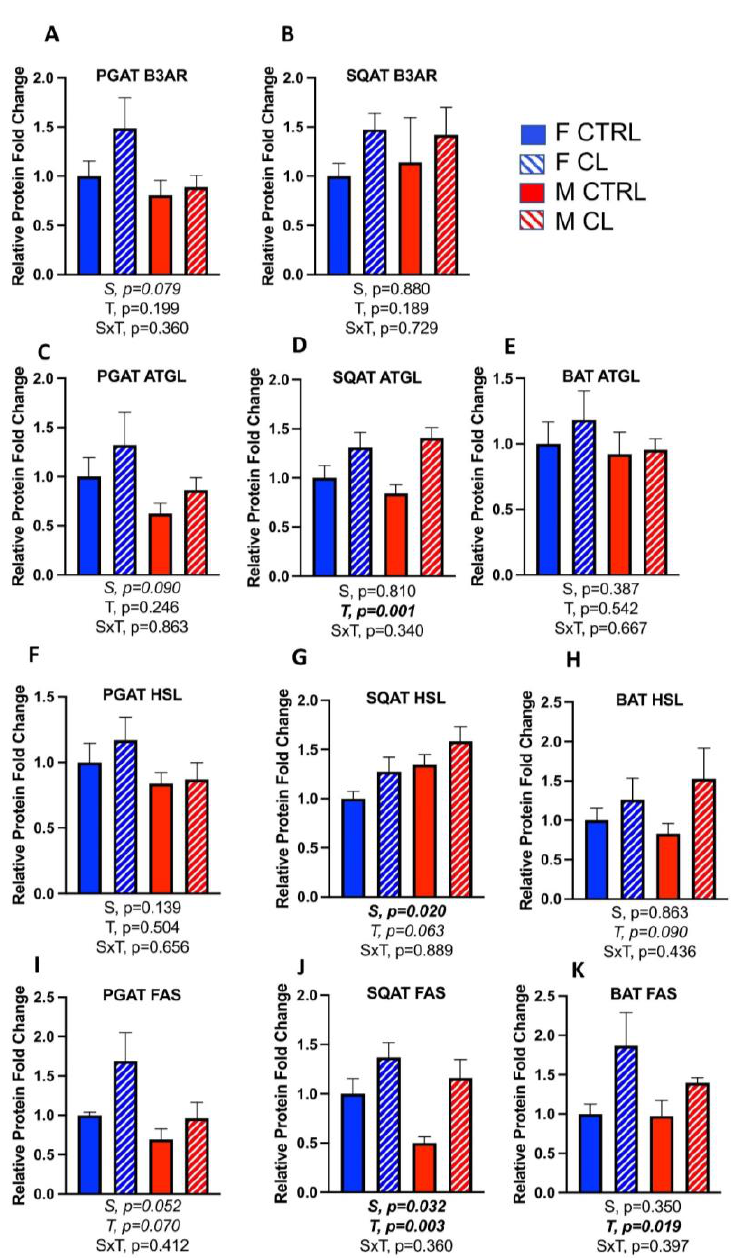
Figure 8. Male (M) and female (F) C57BL/6J mice, all on HFD, were treated for 2 weeks with daily CL injections (1 µ g/g body weight) or CTRL (saline). Perigonadal (PGAT), subcutaneous (SQAT) and brown (BAT) adipose tissue depots were collected and markers of de novo lipogenesis and lipolysis pathways were measured via Western blot. Beta-3 Adrenergic Receptor (B3AR); Adipocyte Triglyceride Lipase (ATGL); Hormone-Sensitive Lipase (HSL); Fatty Acid Synthase (FAS). ( A ) PGAT B3AR; ( B ) SQAT B3AR; ( C ) PGAT ATGL; ( D ) SQAT ATGL; ( E ) BAT ATGL; ( F ) PGAT HSL; ( G ) SQAT HSL; ( H ) BAT HSL; ( I ) PGAT FAS; ( J ) SQAT FAS; ( K ) BAT FAS. Representative Western blot images (data expressed as relative blot intensity relative to beta actin) are provided as a Supplementary Figure. All data are presented as mean ± SEM, relative to the F CTRL. N = 7–9/group. Main effects of sex (S), CL treatment (T) and sex by treatment interactions (S × T) were determined by 2 × 2 ANOVA and are presented below the respective figures. p -values < 0.05 were accepted as